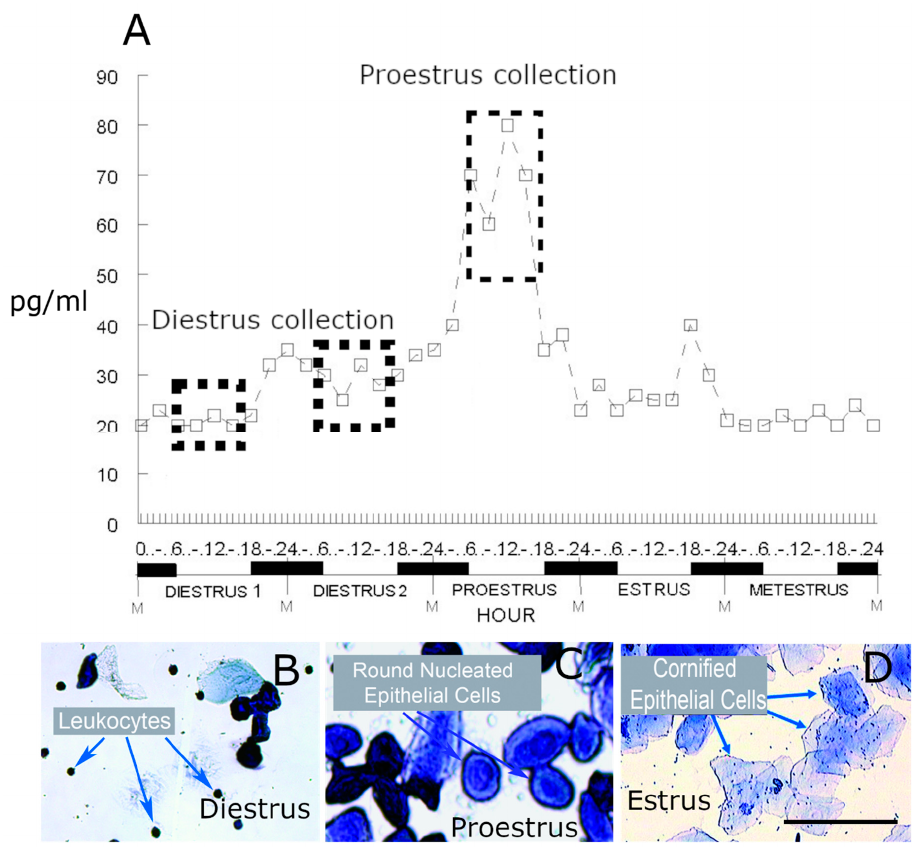
Figure 1. In panel ( A ) the mean concentration values (pg hormone / mL of blood plasma) for 17 β -estradiol during the estrous cycle of intact, female rats, used with permission, Butcher et al., 1974 [39]. Vaginal smears during the light phase are shown for diestrus (panel B ), proestrus (panel C ) and estrus (panel D ). The predominant type of cell present during a particular estrous phase is described on the panels ( B – D ). Animals were sacrificed during the light phase during diestrus and proestrus (dotted boxed regions in panel A ). M = Midnight. Bar = 100 µM Table 1. Rat estrous phase information for samples used in RNA-seq. Table 2. RNA-seq gene expression in parabrachial after injection of control or varicella zoster virus.